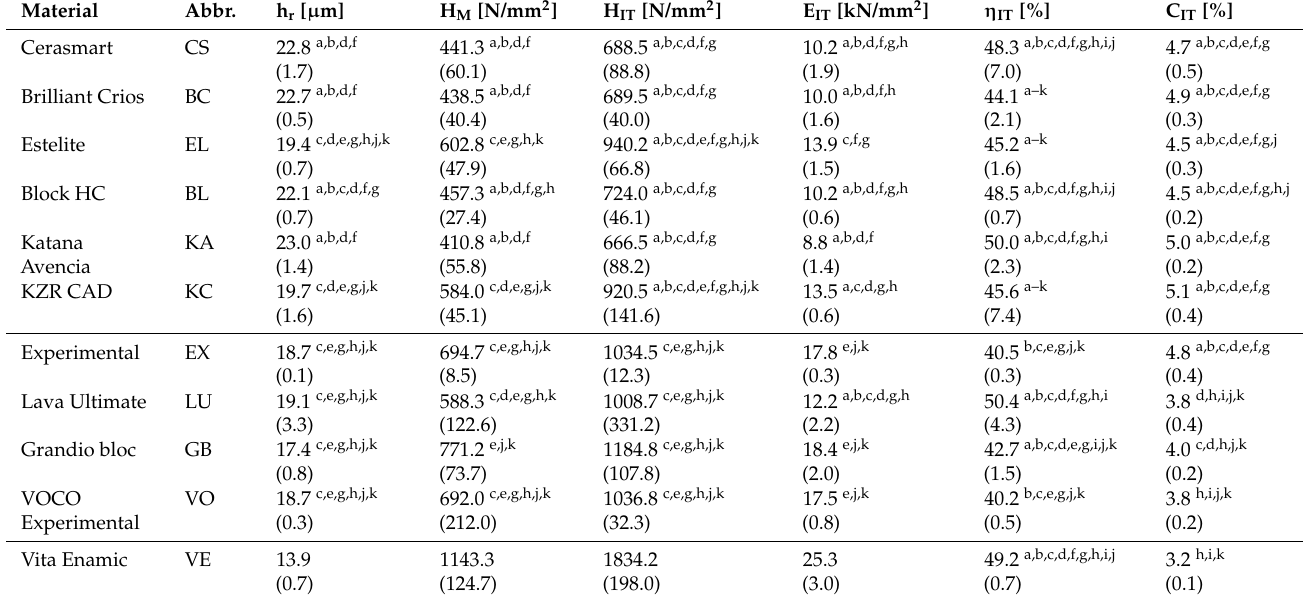
Table 2. Material, abbreviation (Abbr.), mean and standard deviation (in brackets) for indentation depth (h r ), Martens hardness (H M ), indentation hardness (H IT ), indentation modulus (E IT ), elastic part of indentation work ( η IT ), and indentation creep (C IT ). Identical superscript letters indicate column-wise non-significant (Bonferroni post hoc test, p > 0.05) differences between the